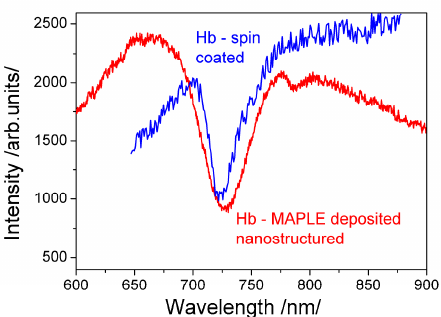
Figure 6. SPR excitation comparing the effectiveness of both immobilization techniques: MAPLE (red curve) and spin coating (blue curve).